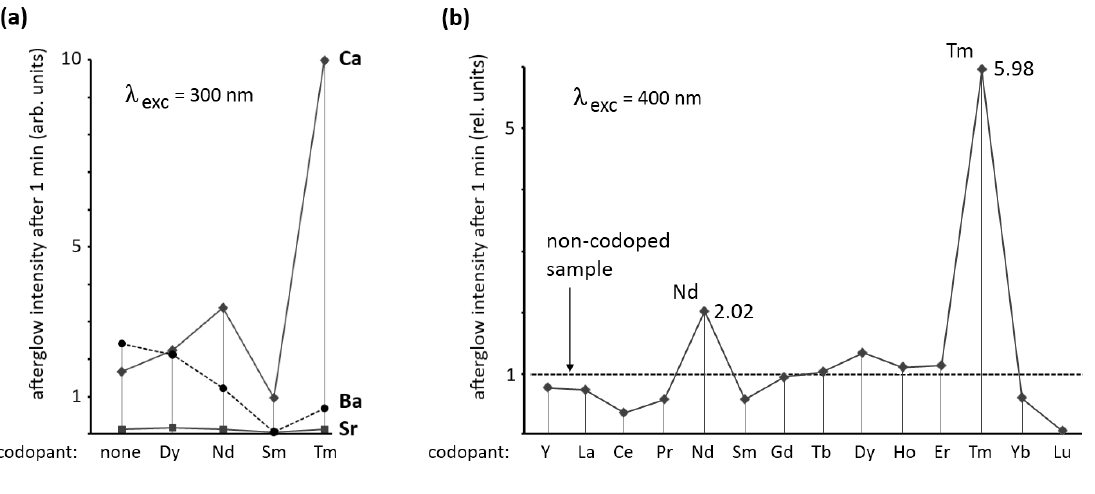
Figure 4. (a) Afterglow intensity of M with 300 nm light, as a function of the codopant; (b) Afterglow intensity of Ca 1 min after excitation with 400 nm light, as a function of the